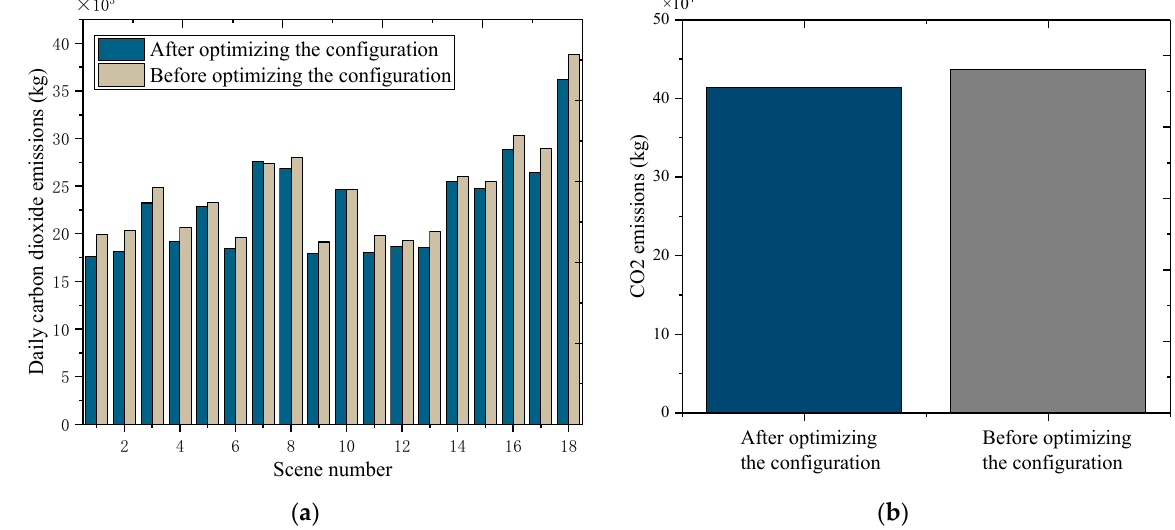
Figure 19. ( a ) System CO 2 emissions in each scenario; ( b ) total carbon dioxide emissions of the system in all scenarios.